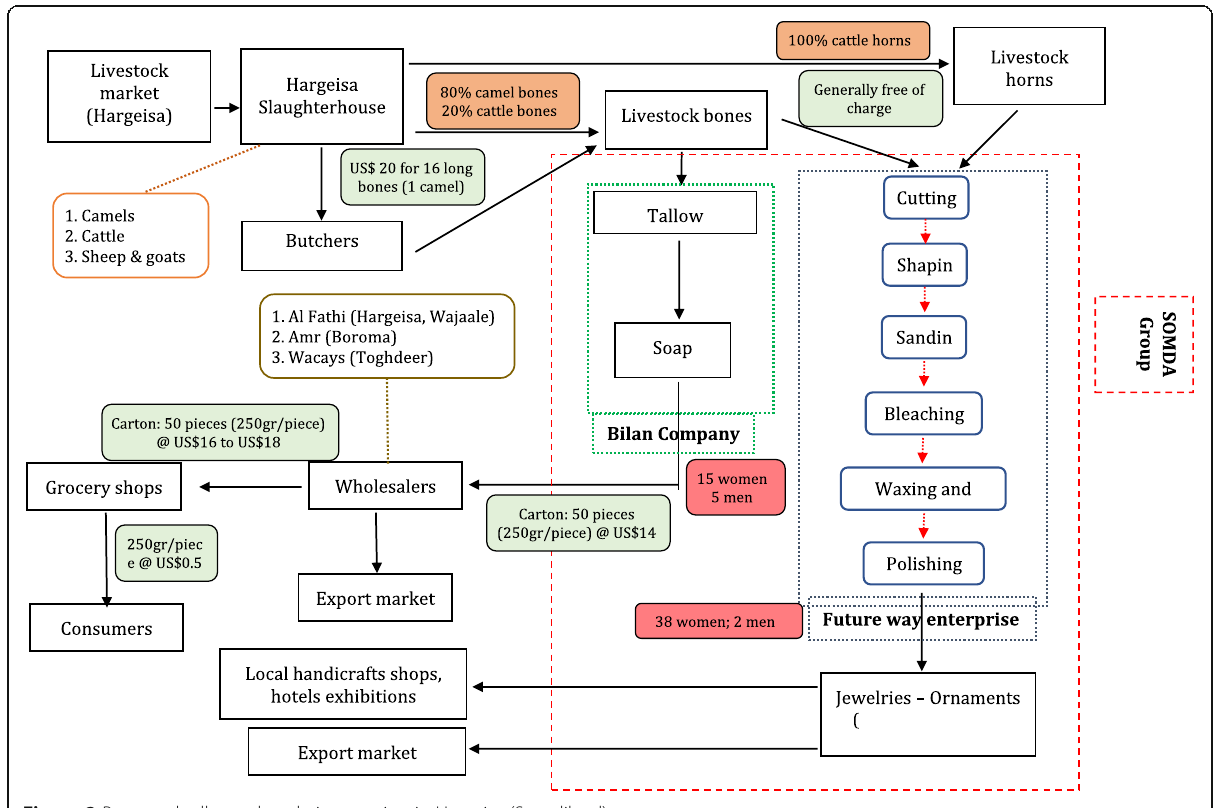
Figure 2 Bone and tallow value chain mapping in Hargeisa